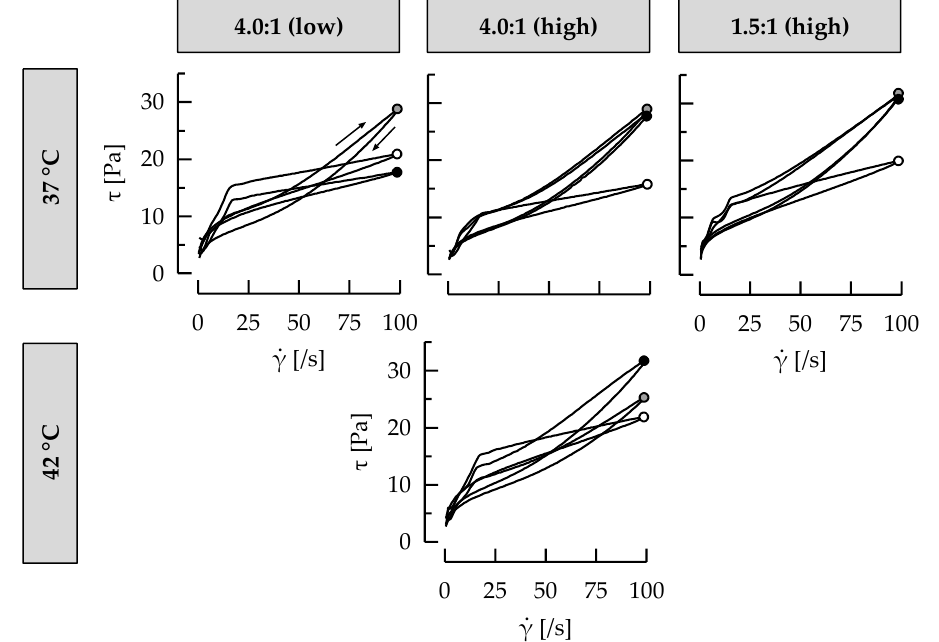
Figure 6. Shear stress ( τ ) versus shear rate ( γ ) ( n = 1) of stirred gels produced with ST-1G+ (white), ST-2E+ (grey) or ST-2F (black) after 3 d of cold storage. Gels were produced from base milk with casein:whey protein ratio of 4.0:1 or 1.5:1 by inoculation with low- or high-activity starters, fermentation temperature was 37 °C or 42 °C. Arrows indicate direction of measurement.